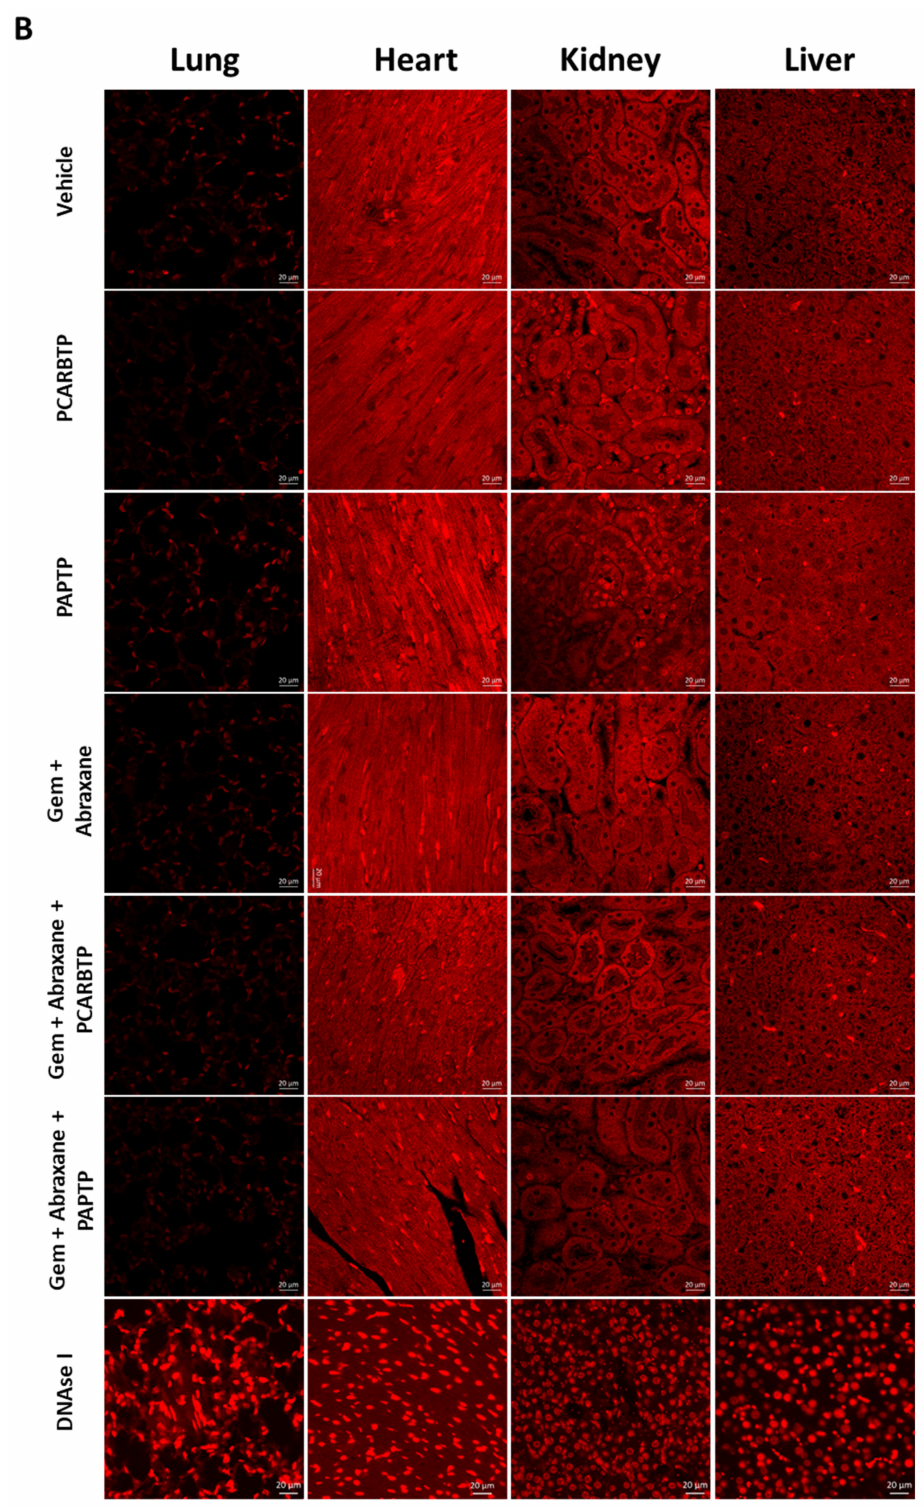
Figure 6. Lack of PCARBTP/PAPTP toxicity on other organs in a mouse model. ( A ) H&E staining showed either PCARBTP or PAPTP intraperitoneal administration alone or combined with Gem- citabine and Abraxane had no toxic effect on the heart, lung, kidney, or liver. Scale bar = 20 µ m. ( B ) TUNEL assay performed on the respective organs. DNase treatment was used as a positive control. There was lack of toxicity in the lung, heart, kidney and liver when treated with PCARBTP or PAPTP alone or when combined with cytotoxic chemotherapies. Scale bars, 20 µ